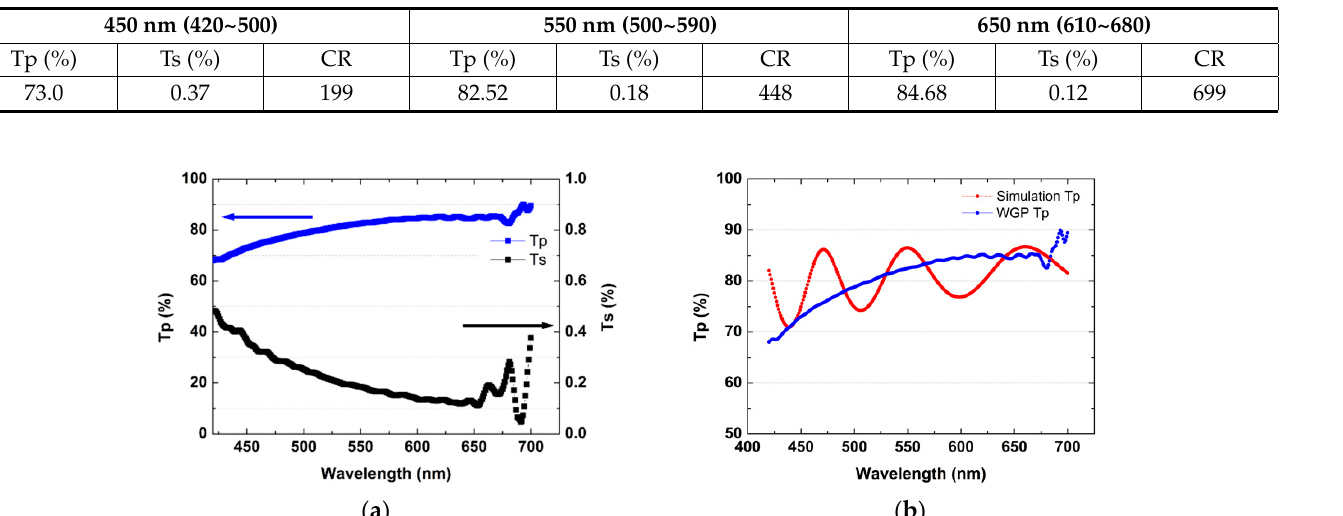
Figure 8. ( a ) WGP Tp, Ts and ( b ) Measurement transmittance of Simulation and WGP.